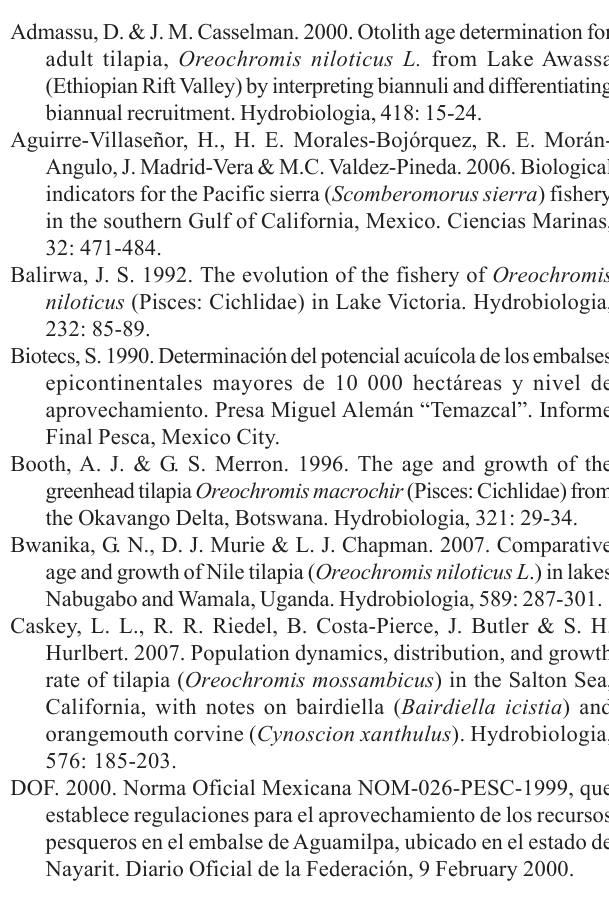
Fig. 6. ( a ) Relationship between relative condition index and surface temperature; ( b ) Relationship of condition index and percentage of Sinaloa cichlid Cichlasoma beani females in Stages IV and V of the maturity scale of Nikolsky (1963) in the Aguamilpa Reservoir, Mexico.